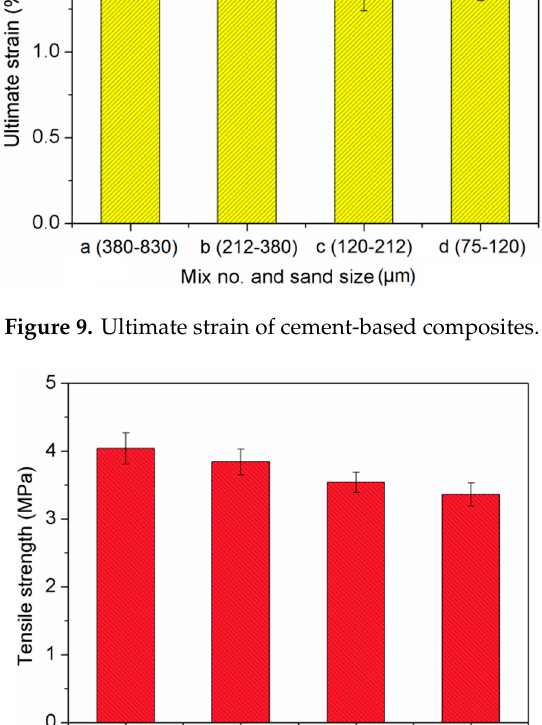
Figure 11. Relationship between load and mid-span deflection.